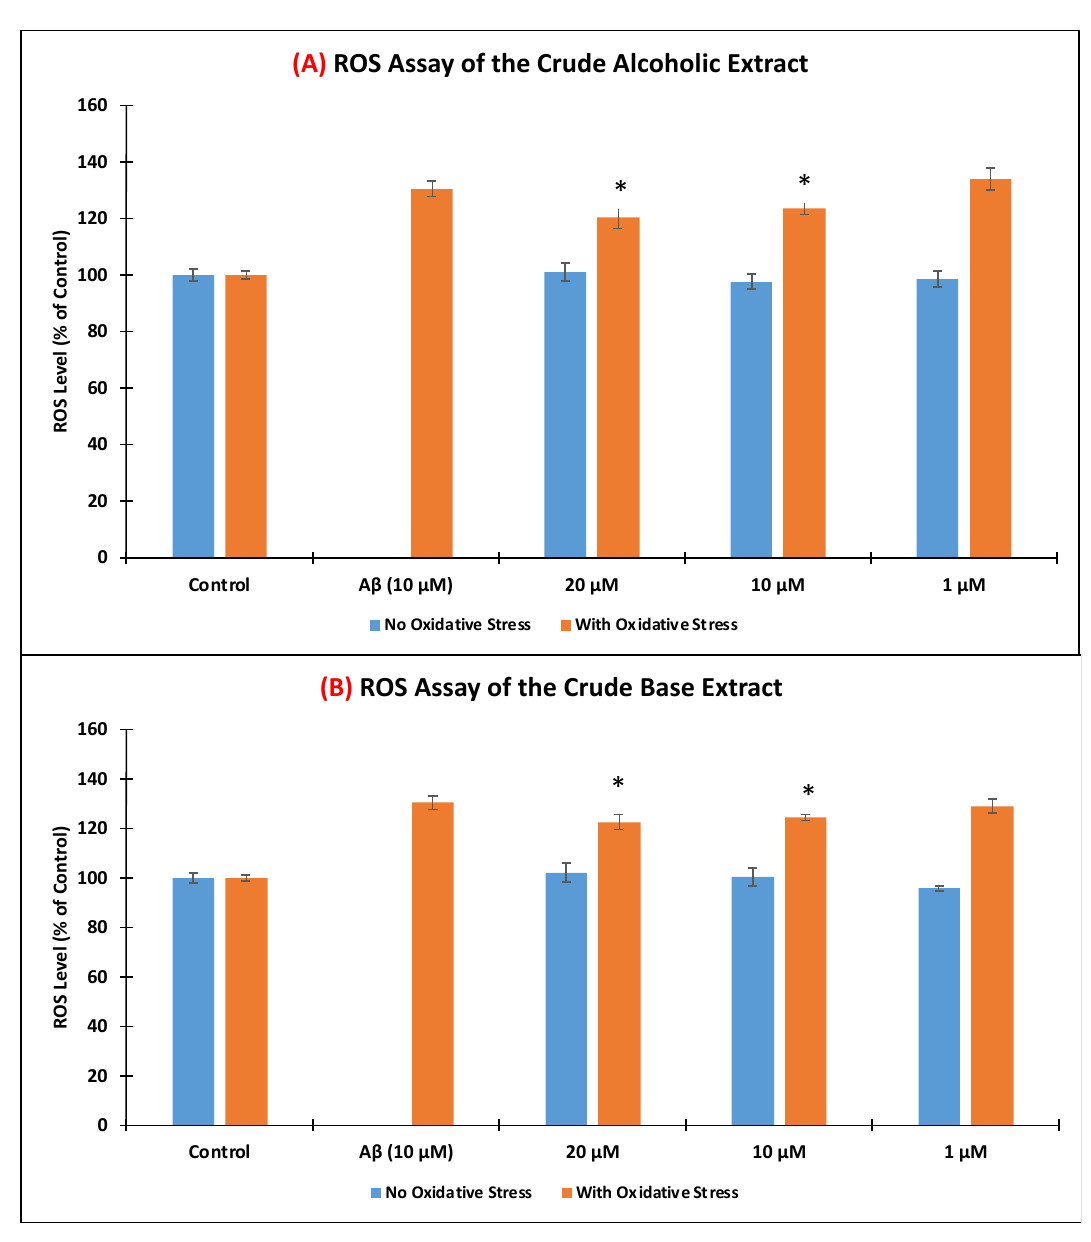
Figure 4. Effects of Pandanus amaryllifolius ( A ) crude alcoholic extract ( A , B ) crude base extract on intracellular ROS accumulation using the 2 ′ ,7 ′ - dichlorodihydrofluorescein diacetate (H 2 DCFDA) reagent. Neuroblastoma SH-SY5Y cells were incubated with the extracts for 6 h, followed by 10 μ M A β for 24 h. “No Oxidative Stress” indicates non-A β treated cells. Intracellular ROS level (% of the control cells) was computed as mean ± SD of triplicate experiments. The (*) represents statistical difference ( p < 0.05) of the ROS level with the A β -treated alone cells.